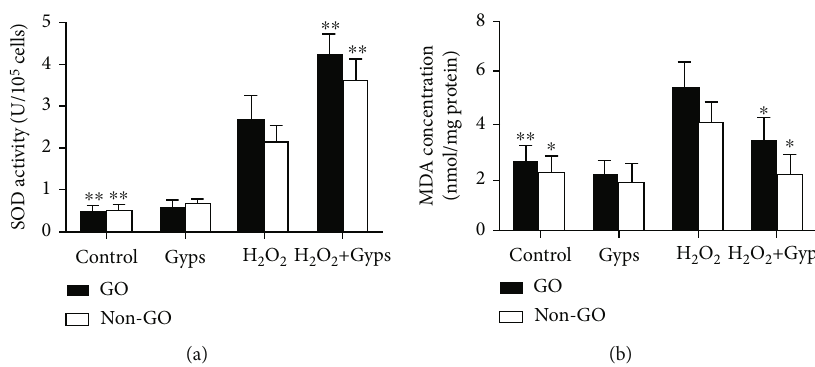
Figure 8: The e ff ect of Gyps on SOD and MDA induced by H O . Gypenoside preintervention can regulate the expression of SOD and 2 2 MDA in orbital fi broblasts of GO patients under H O stimulation. After intervention in accordance with the requirements of the group. 2 2 SOD and MDA kits were used to detect (a) in each group with full-wavelength enzyme labeling instrument. SOD showed that the activity of H O + Gyps increased signi fi cantly, while MDA detection showed that H O +Gyps could inhibit its production. Three 2 2 2 2 samples from each of the three GO and non-GO donors were taken for the experiment. All detections are repeated 3 times, with 3 replicate wells each time ( ∗ as P < 0 : 05 and ∗∗ as P < 0 : 01 ; P < 0 : 05 means the di ff erence is statistically signi fi cant, and P value is analyzed by two-way